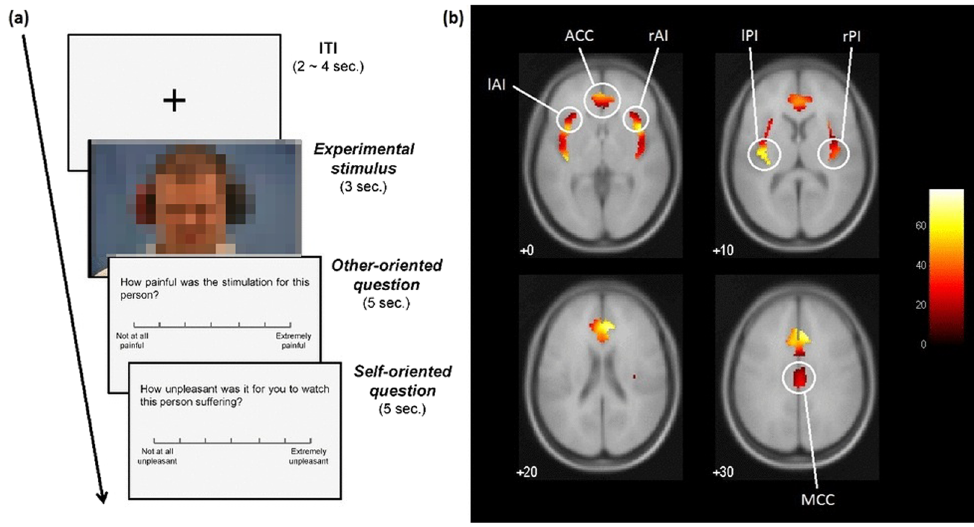
Figure 6. Task schematics and results for the empathy localizer task. ( a ) The videos showed individuals receiving auditory stimulation and displaying the transition from neutral facial expression (0.5 s) to exhibiting painful facial expressions (2.5 s). After presentation of each painful video, participants responded to two questions: one assessing other-oriented empathic response by gauging intensity of the experienced pain, while the other assessing self-oriented distress via experienced unpleasantness. The face of the target has been pixelated to protect the identity of the person in photo. ( b ) Brain regions where the BOLD signal was higher while watching painful videos as compared to baseline ( n = 49, group-level random effects analysis, p < 0.05, FWE-corrected, k > 10), masked with Neuromorphometrics anatomical atlas labels for ROIs. The slice numbers represent z -coordinate in MNI stereotactic space and the color bar denotes the F -statistic. Regions of Interest (ROIs) are highlighted and labeled. Abbreviations : ACC: anterior cingulate cortex, AI: anterior insula, MCC: midcingulate cortex, PI: posterior